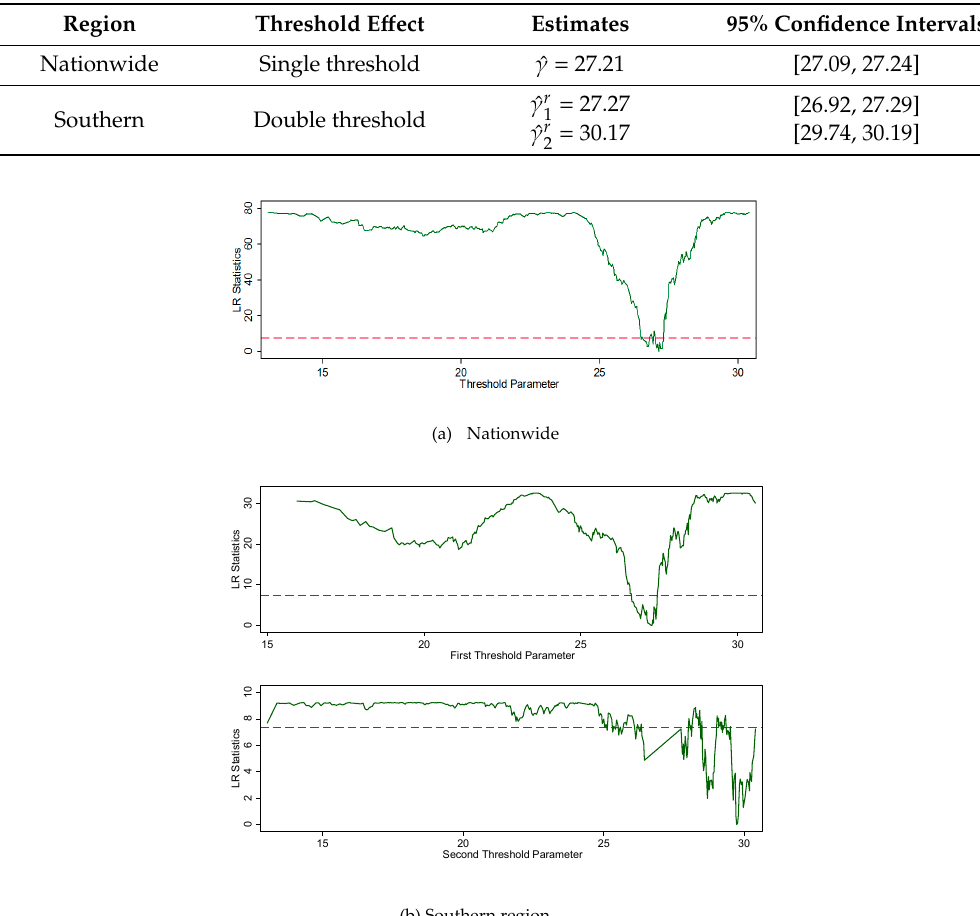
Table 3. Temperature threshold estimates.